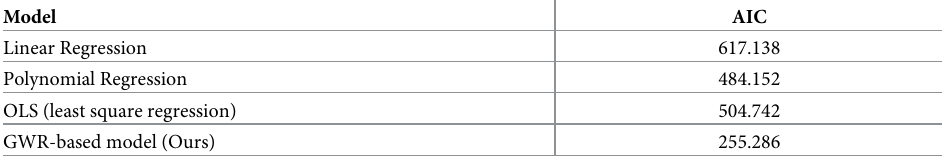
Table 5. Comparison amongst different methods.